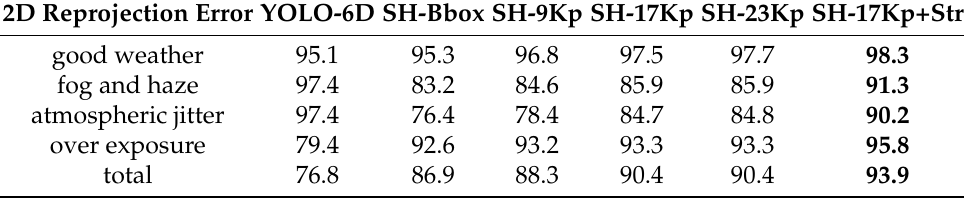
Table 9. Discussion on APE dataset. Bold number indicates the best result.